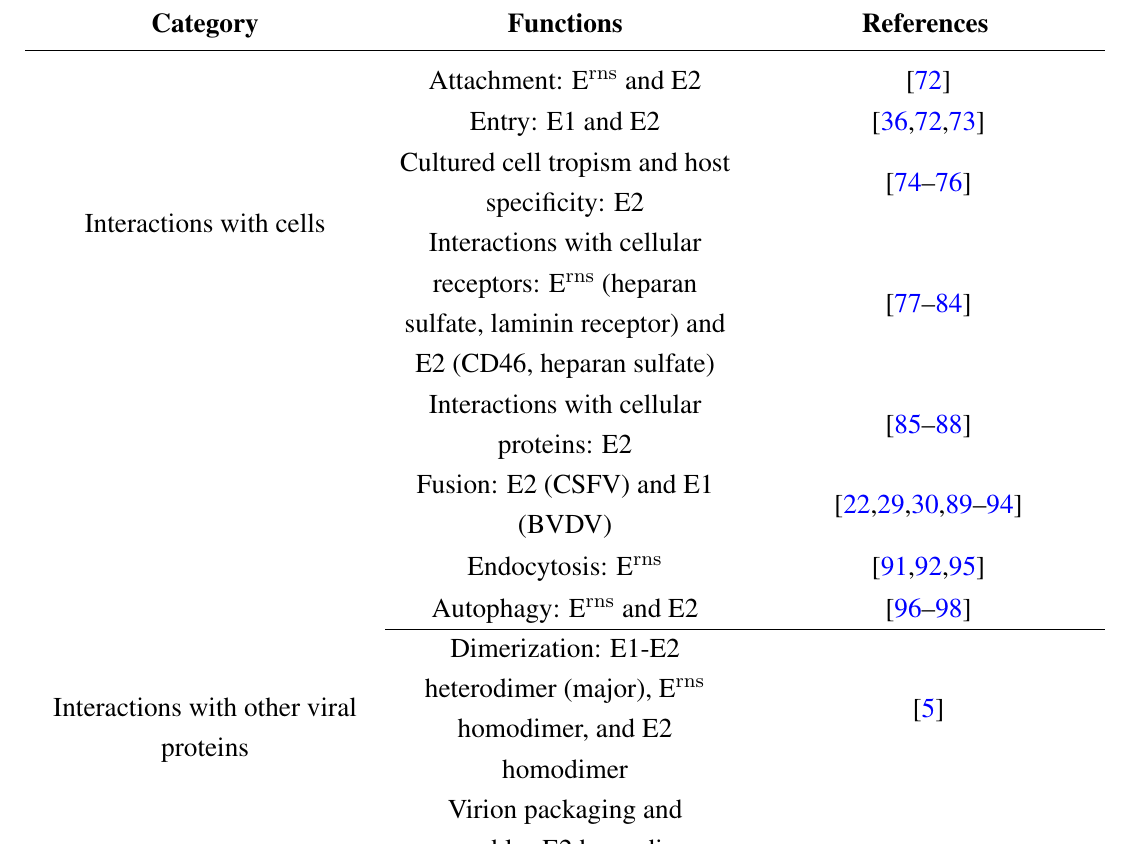
Table 1. Functions of the pestivirus glycoproteins during the viral life